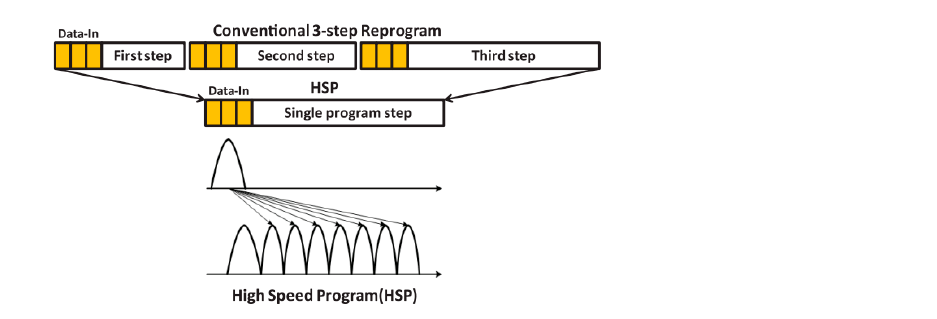
Figure 3. High-speed program (HSP) of V-NAND. Reprinted/adapted with permission from Ref. [35], 2016, IEEE.